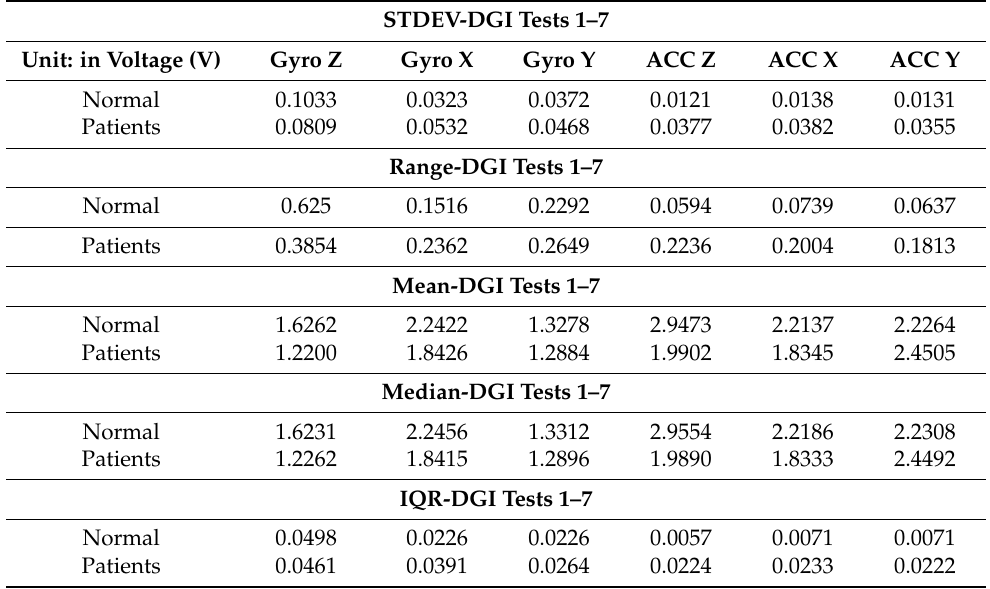
Table 5. STDEV, range, mean, median and IQR of all DGI Tests 1–7 data averaged for all normal subjects vs.